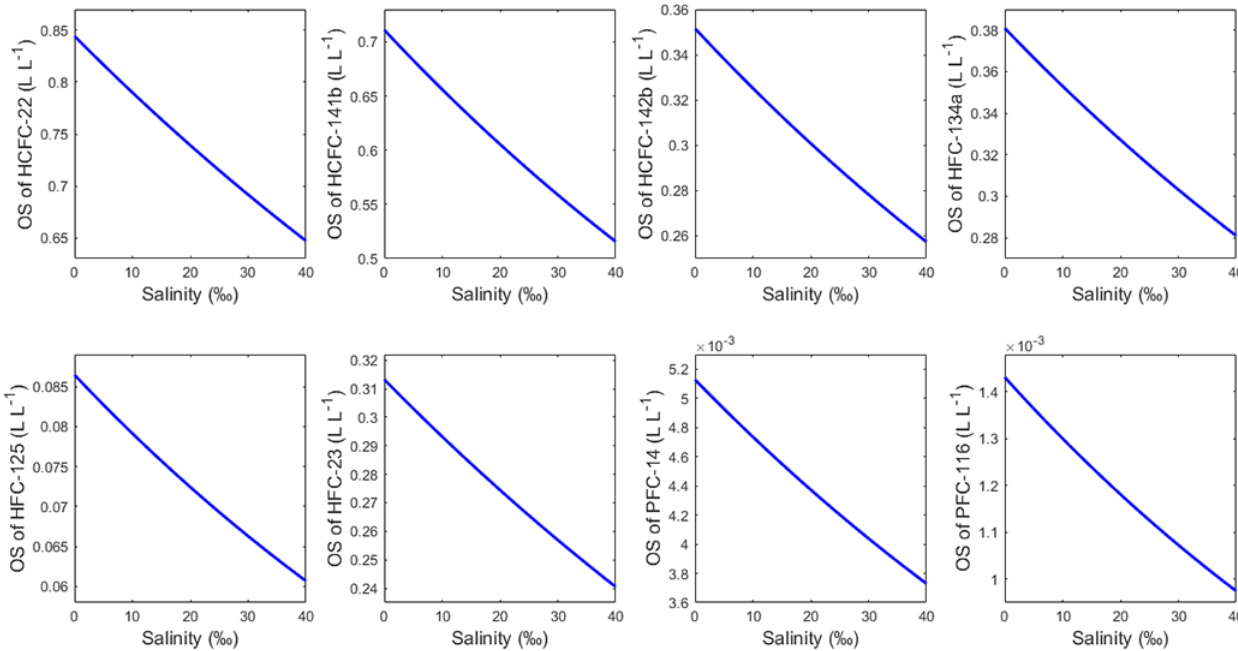
Figure 4. Salinity dependence of the Ostwald solubility (OS) coefficients in seawater for HCFC-22, HCFC-141b, HCFC-142b, HFC-134a, HFC-125, HFC-23, PFC-14 and PFC-116 at a temperature of